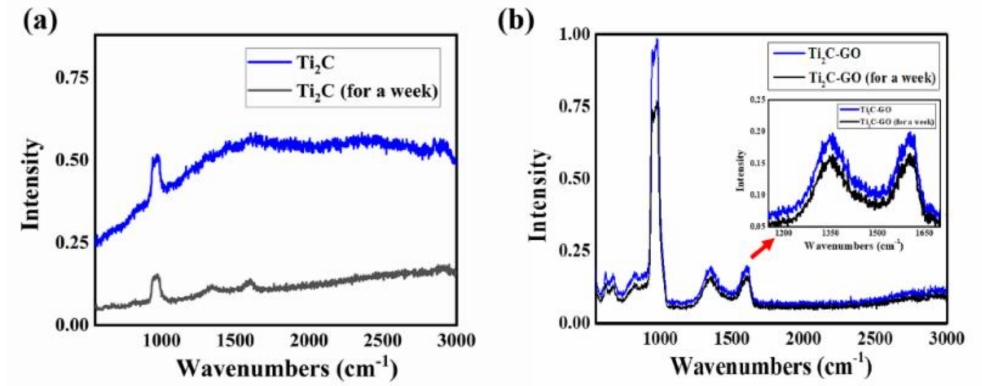
Figure 7. Stability test of the MXene–GO heterojunction: ( a ) Raman spectra of pure MXene (Ti 2 C) exposed to air for 0 days or a week; ( b ) Raman spectra of the pure MXene–GO heterojunction exposed to air for 0 days or a week.